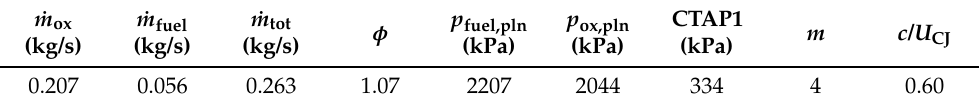
Table 2. Summary of flow parameters for a straight annulus run with φ = 1.07 and ˙ m tot = 0.263